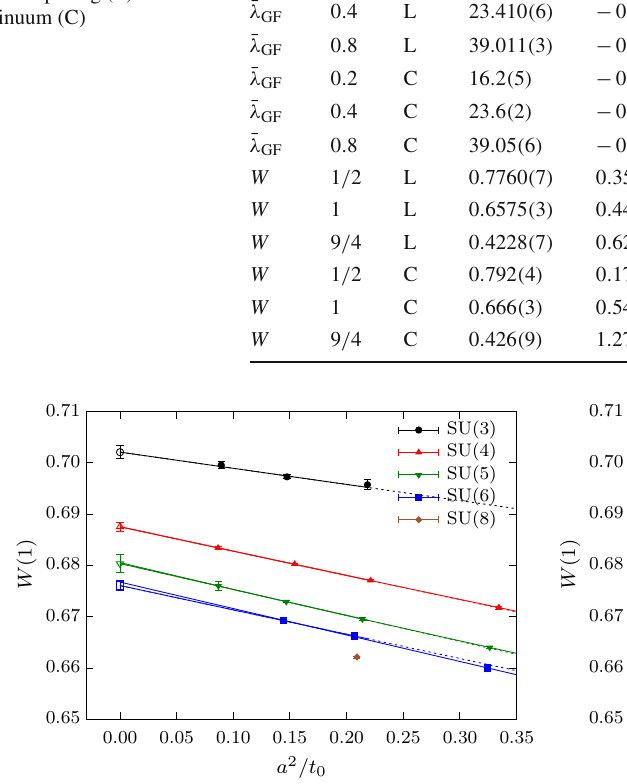
Table 2 Parameters of the large N extrapolations, eq. (5.2), of √ ¯ λ ( 1 / 8 ct 0 ) and W ( c ) at GF finite lattice spacing (L) and in the continuum (C)